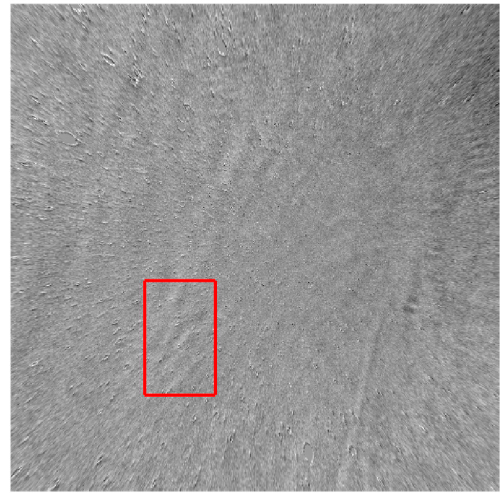
Figure 13. The misjudged airglow image. This image containing dim GW structure was captured at 1:09:12 on 26 January 2014. The manual check found the GW pattern in this image, while the auto-extraction failed to pick this out. The region with highest confidence value (21.1%) is labeled with red rectangle.